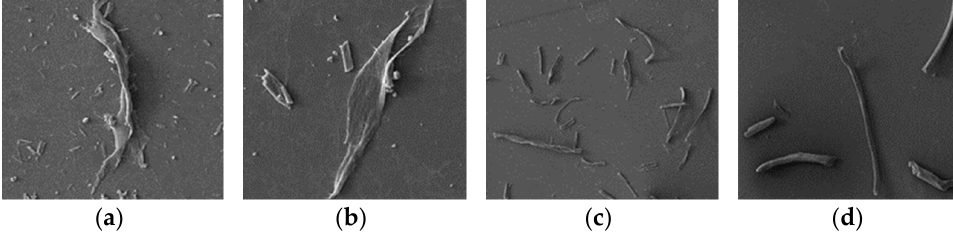
Figure 8 . Morphology of the pretreated cotton fiber at different growth stages, ( a ): XM-1, ( b ): XM-2, ( c ): XM-3, ( d ): XM-4.